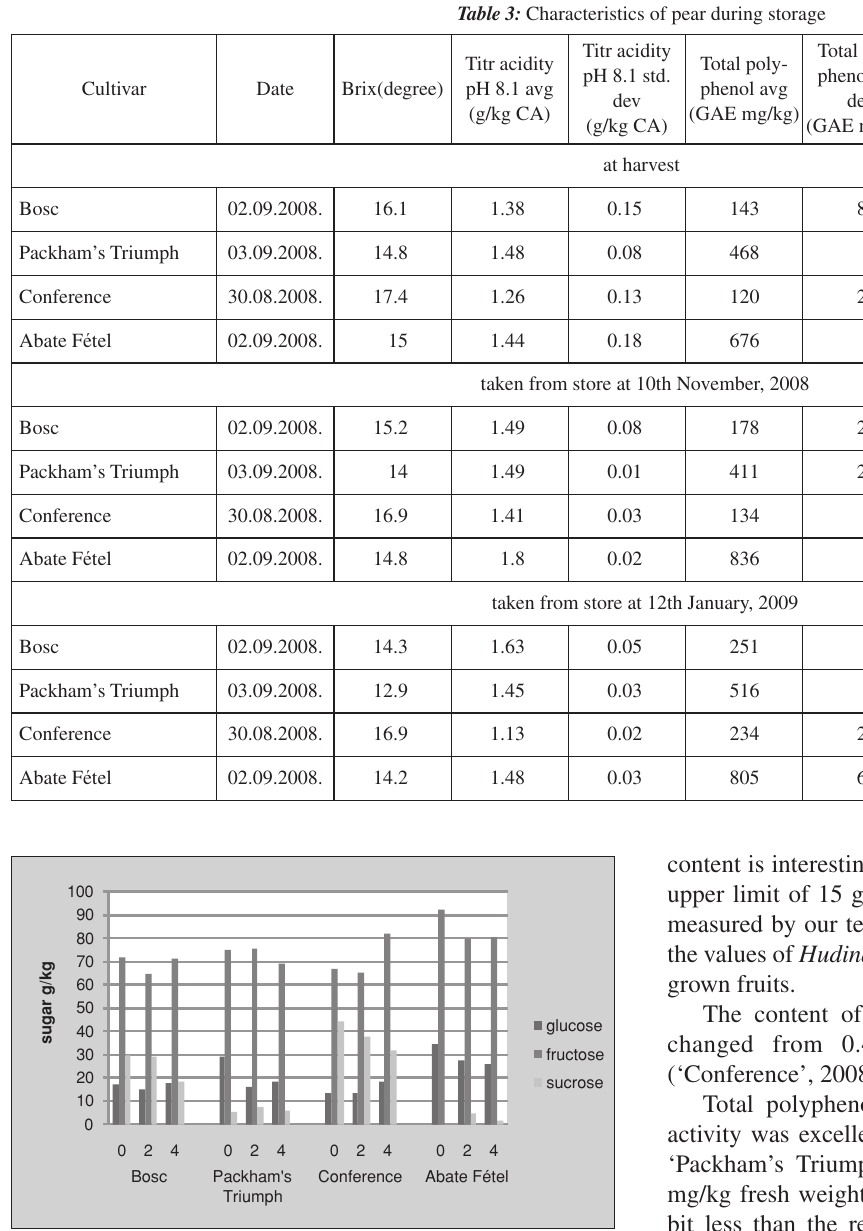
Figure 2: Change in sugar components during 4 months storage